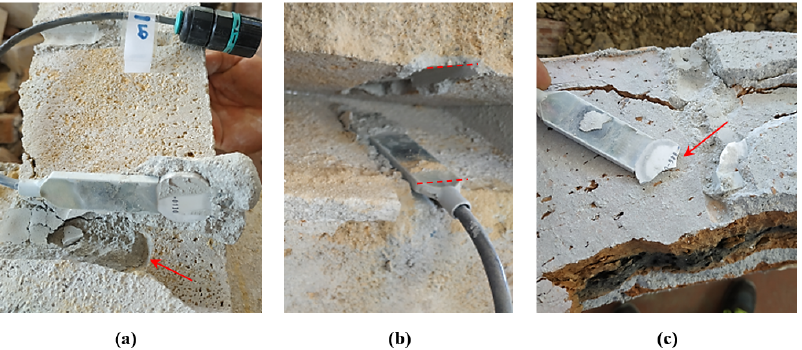
Figure 11. Installation defects: ( a ) discontinuity in the section; ( b ) sensor rotation; ( c ) sensor